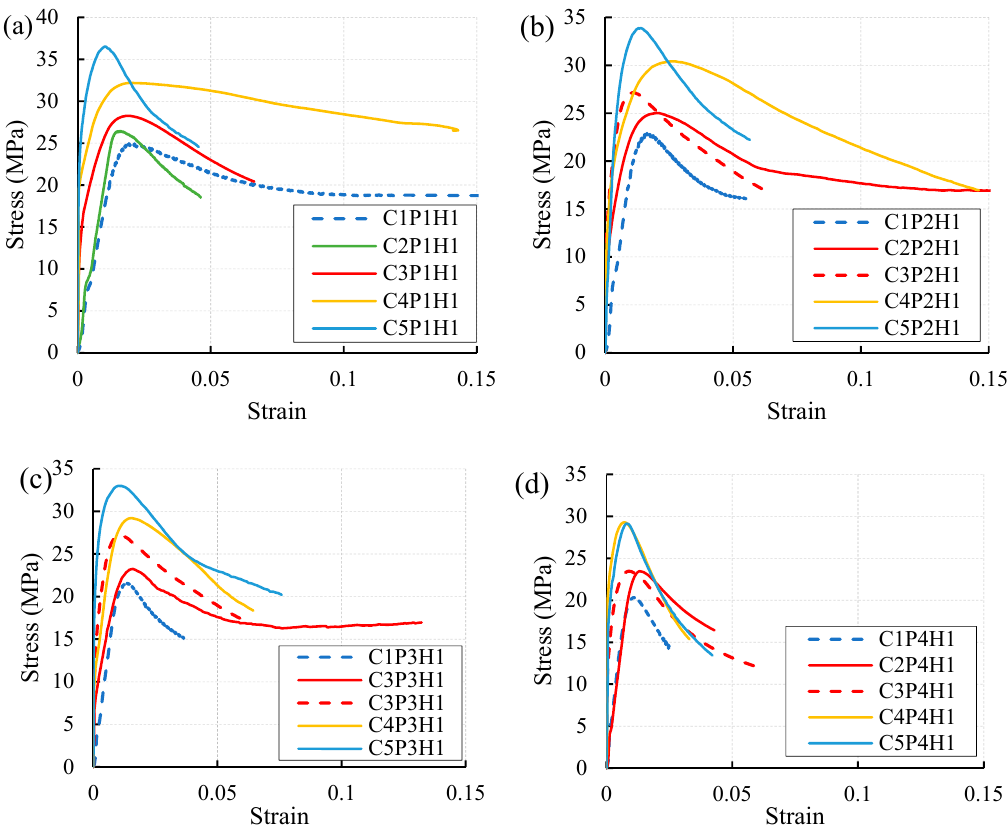
Figure 16. Stress-Strain curve of different classes of concrete filled uPVC tube cylinders for uPVC size of: ( a ) 63 mm, ( b ) 90 mm, ( c ) 110 mm, and ( d ) 140 mm.